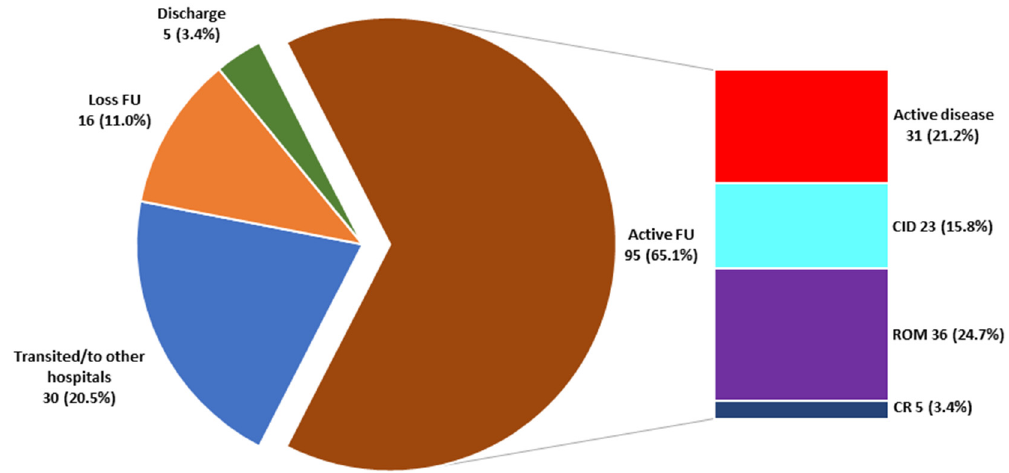
Figure 2. Number and proportion of enthesitis-related arthritis patient status at their last visit ( n = 146). FU = follow-up, CID = clinical inactive disease, ROM = remission on medication, CR = clinical remission off medication.